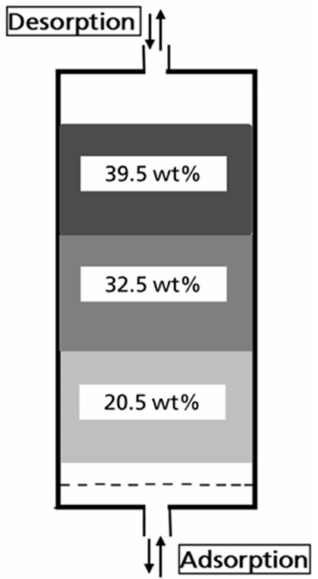
Figure 7. Water content of the activated carbon bed after adsorption in the 300th